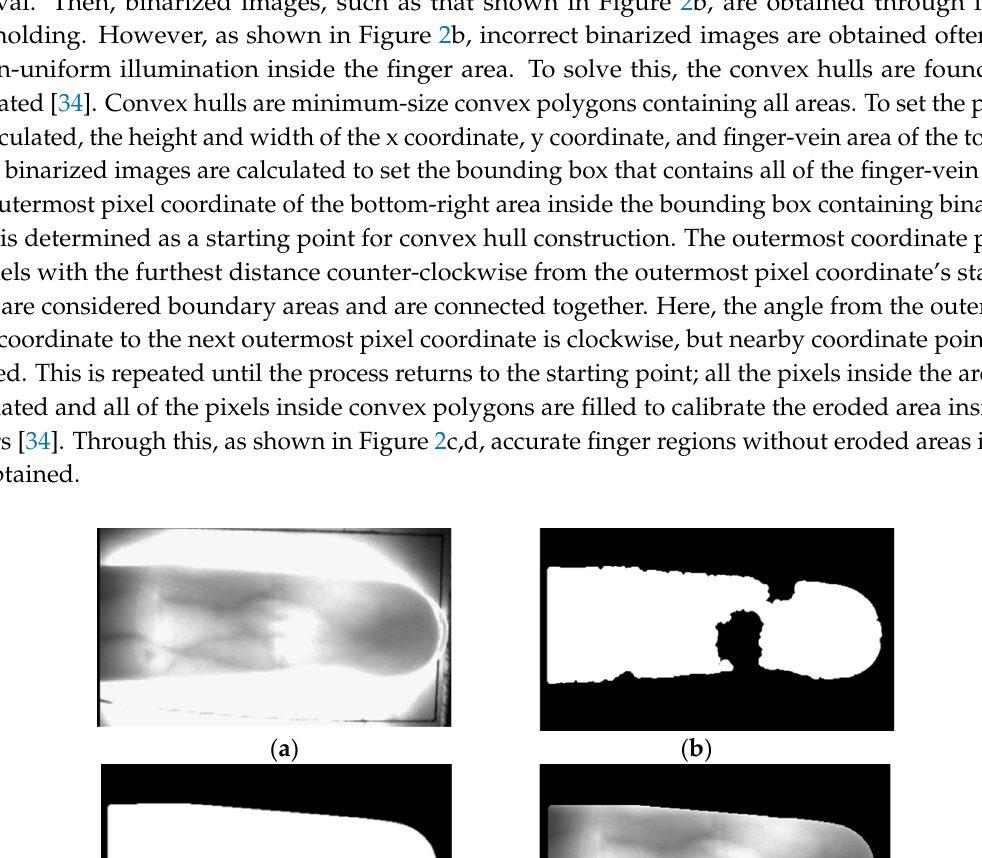
( d ) Figure 3. Examples of in-plane rotation compensation: ( a ) original input image; ( b ) extracted finger region by step 2 of Figure 1; ( c ) image by in-plane rotation compensation; and, ( d ) detected finger region-of-interest (ROI).